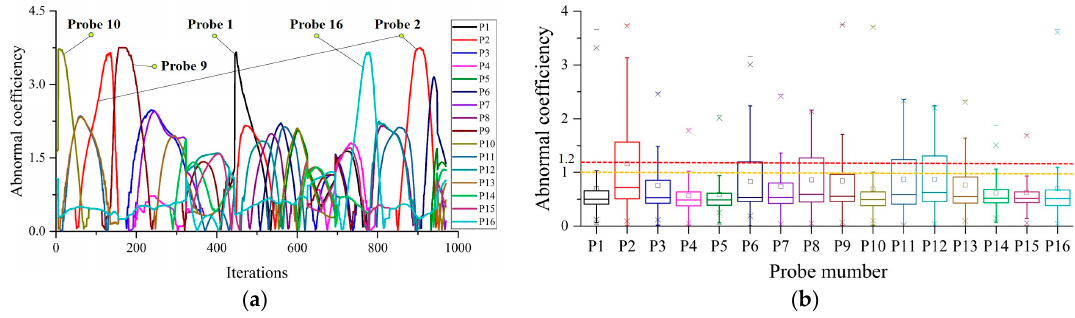
Figure 11. The abnormal coefficient and boxplot at the first 3 h of Vehicle 2. ( a ) The abnormal coefficient curves; ( b ) Boxplot of the abnormal coefficient.